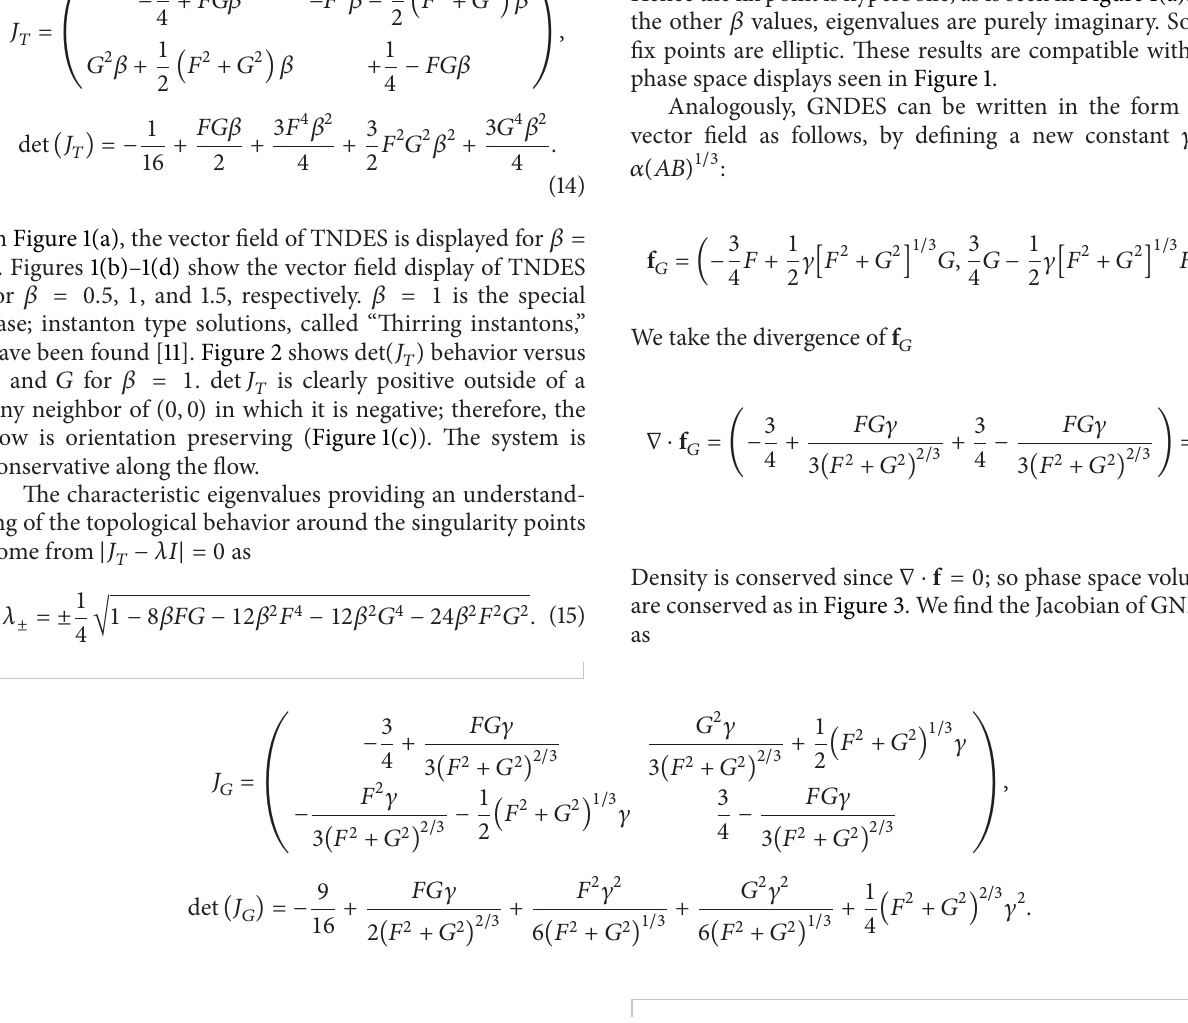
Figure 4 for 𝛾 = 1 . For 𝛾 = 1 , instanton type solutions called “Gursey instantons” have been found [4]. In